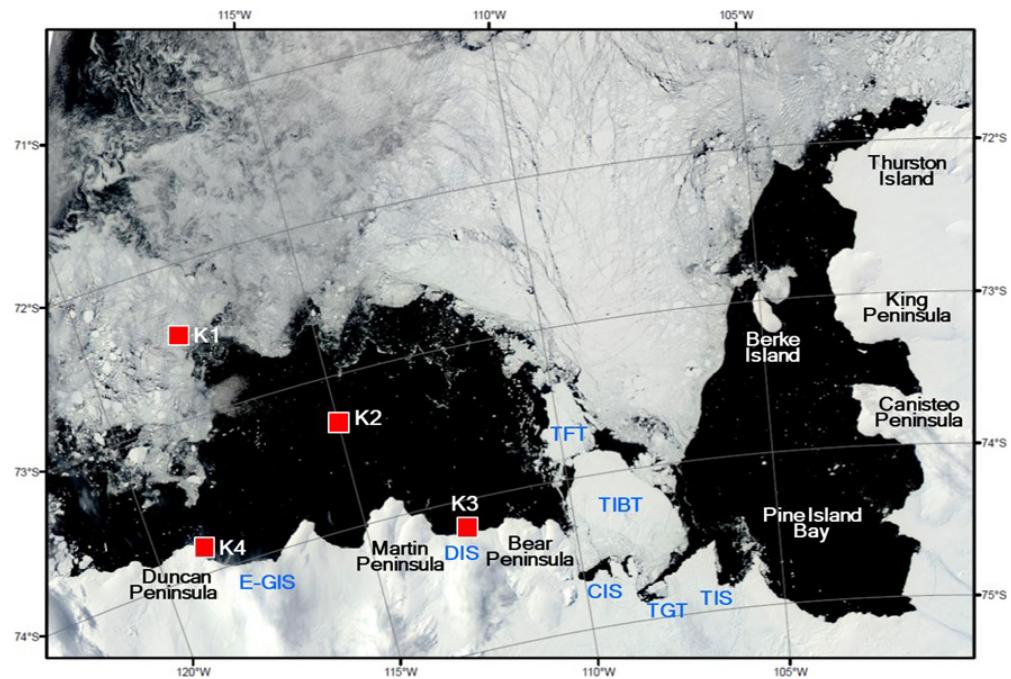
Figure 1. Locations of sediment traps deployed in the Amundsen Sea. The satellite image showing the sea ice distribution was taken on 15 February 2012. The satellite image was obtained from rapid response imagery from the Land, Atmosphere Near real-time Capability for EOS (LANCE) system, operated by the NASA’s GSFC Earth Science Data and Information System (ESDIS). Areas marked from east to west: Thwaites Ice Shelf (TIS), Thwaites Glacier Tongue (TGT), Thwaites Iceberg Tongue (TIBT), Thwaites Fast-ice Tongue (TFT), Crosson Ice Shelf (CIS), Dotson Ice Shelf (DIS), and eastern Getz Ice Shelf